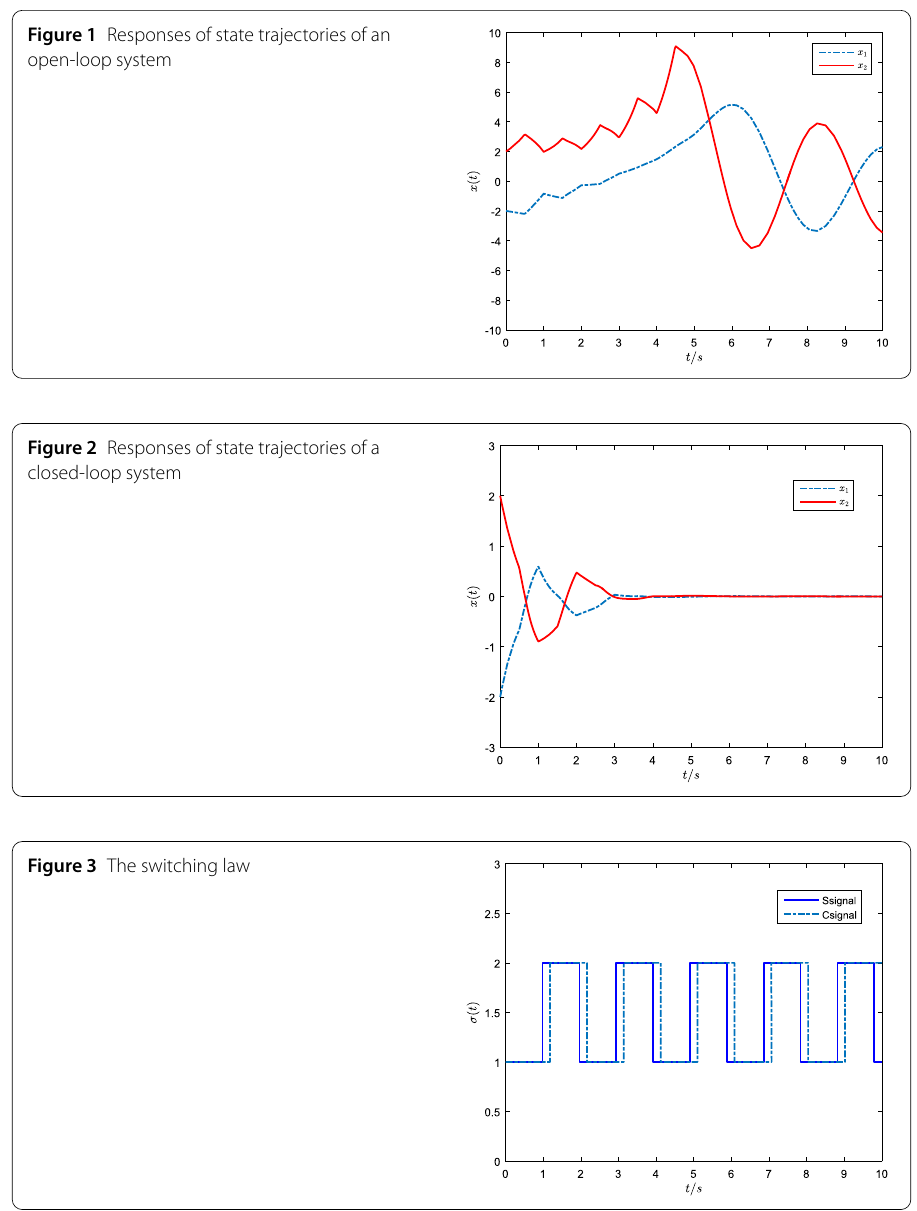
Figure 1 Responses of state trajectories of an open-loop system